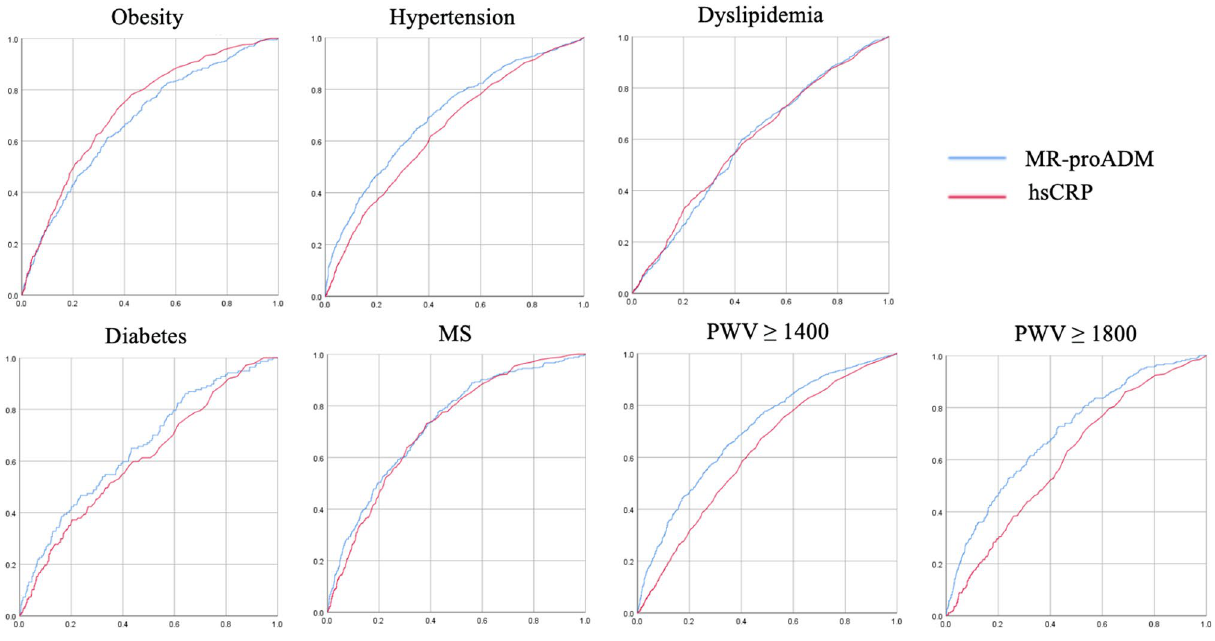
Figure 2. Receiver operating characteristic curve analysis classified cardiometabolic disease and arterial stiffness by MR-proADM and